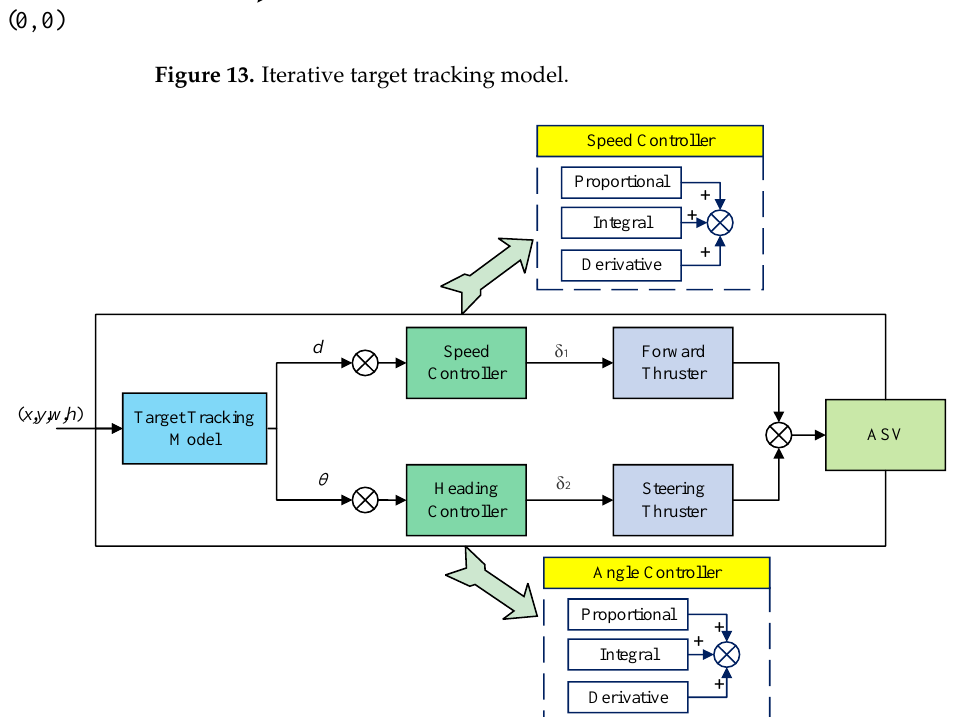
Figure 14. Dicyclic PID control diagram.